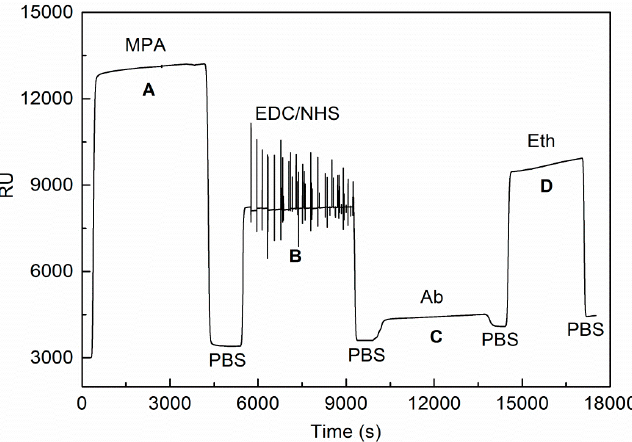
Figure 3. The response unit obtained from the functionalization of biomolecular recognition membrane.